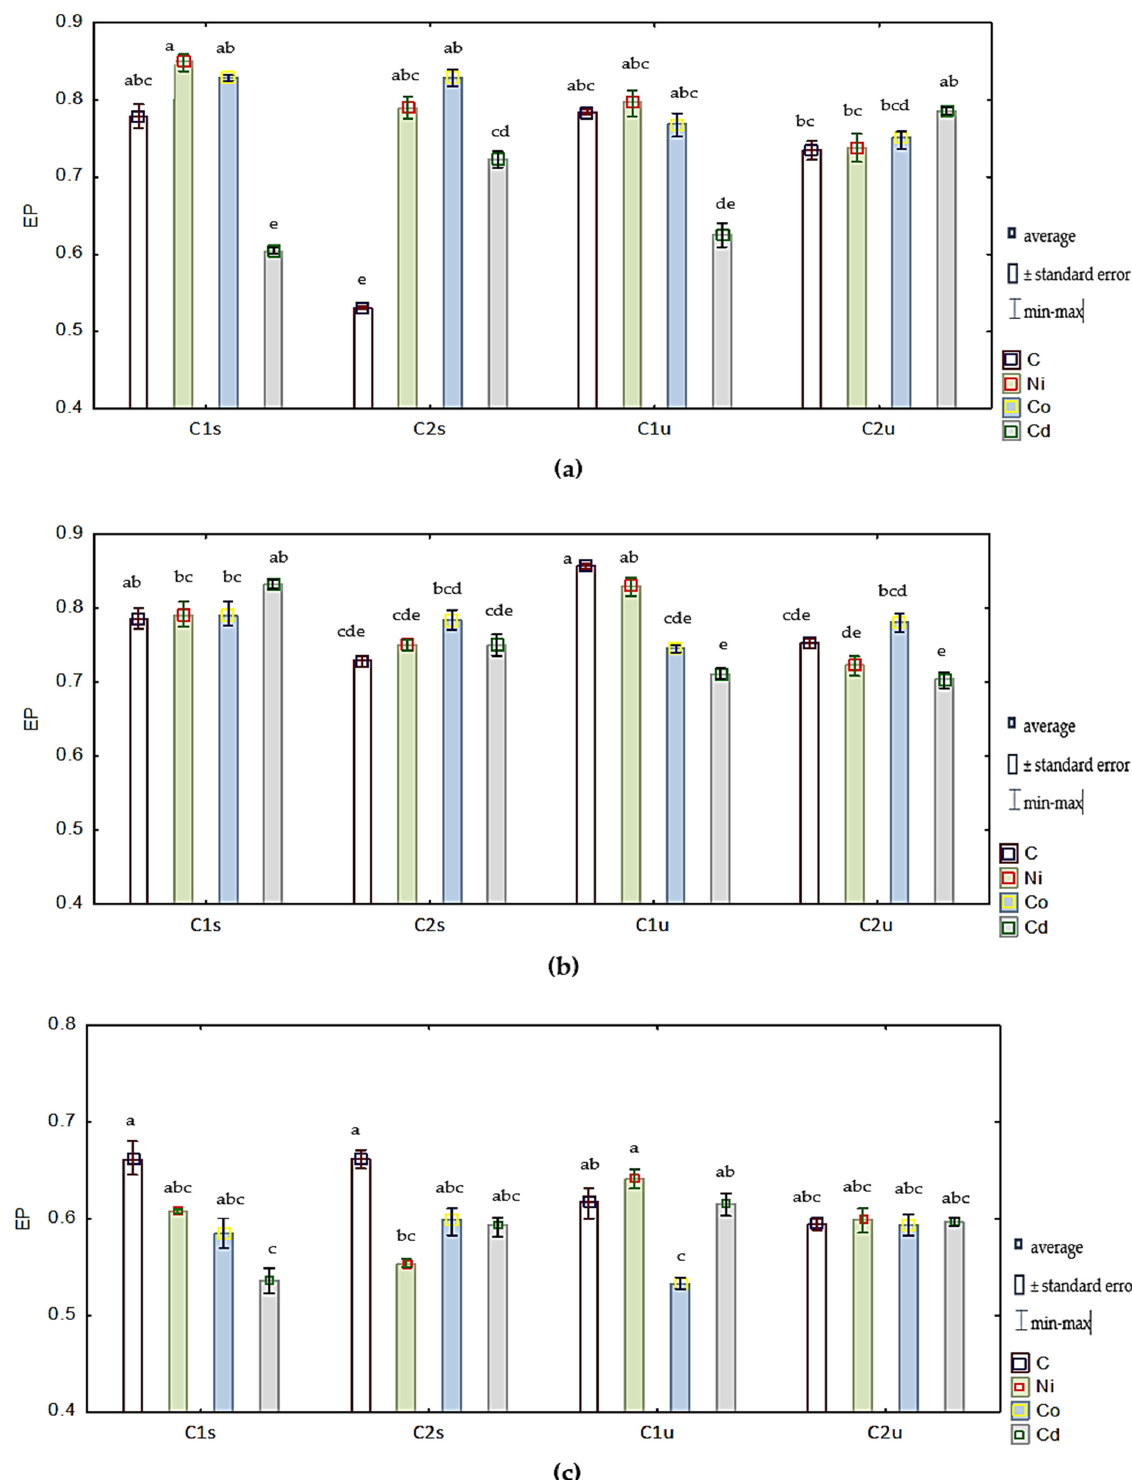
Figure 3. Ecophysiological diversity (EP) index of soil microorganisms. Refer to the key in Figure 2.